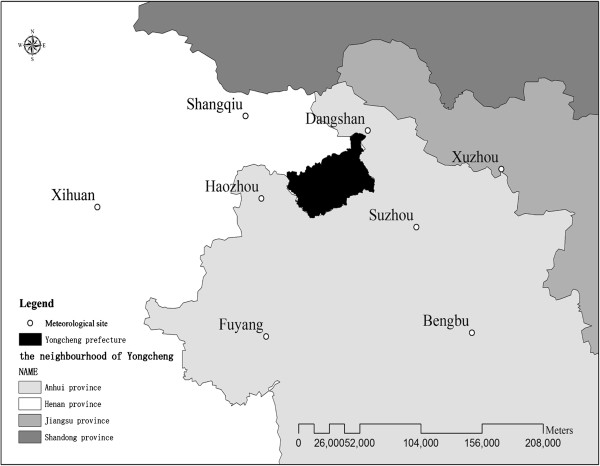
Positions of the eight climatic stations neighbouring Yongcheng prefecture.